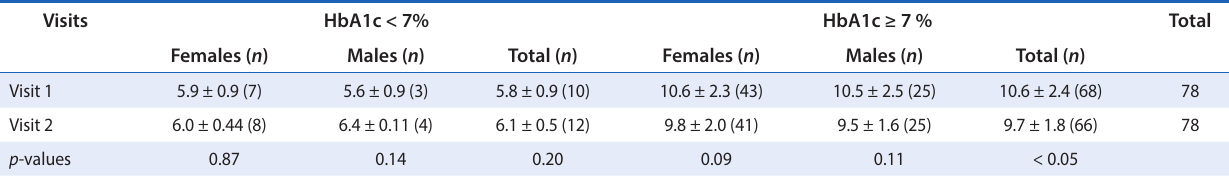
Table 3: Concentration of HbA1c (%) according to gender and total at visits 1 and 2 Visits